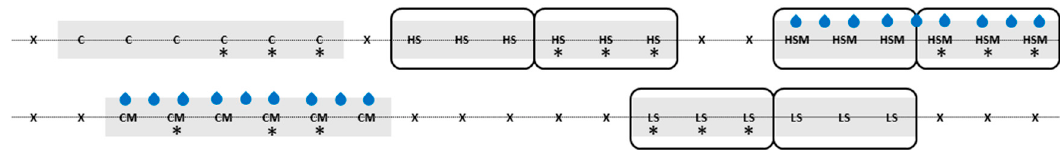
Figure 4. Schematic diagram of treatments (C = control (no smoke exposure); CM = control with misting; LS = low density smoke exposure; HS = high density smoke exposure; HSM = high density smoke exposure with misting), showing the positioning of smoke tents, in-canopy sprinklers ( ), vine replicates (*) and buffer vines ( × ), within the two adjacent rows of Cabernet Sauvignon vines. Two portable environmental sensors (R9 series, Attentis Pty. Ltd., Cheltenham, Vic., Australia)